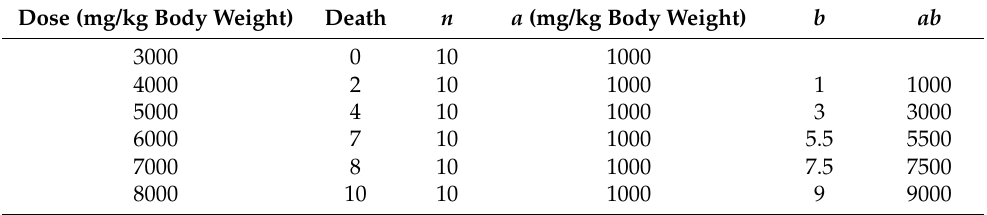
Table 4. Test data for determination of LD 50 values for amoxicillin ( n —number of mice in each group, a —difference between two consecutive doses, and b —average value of the deaths from two consecutive doses).